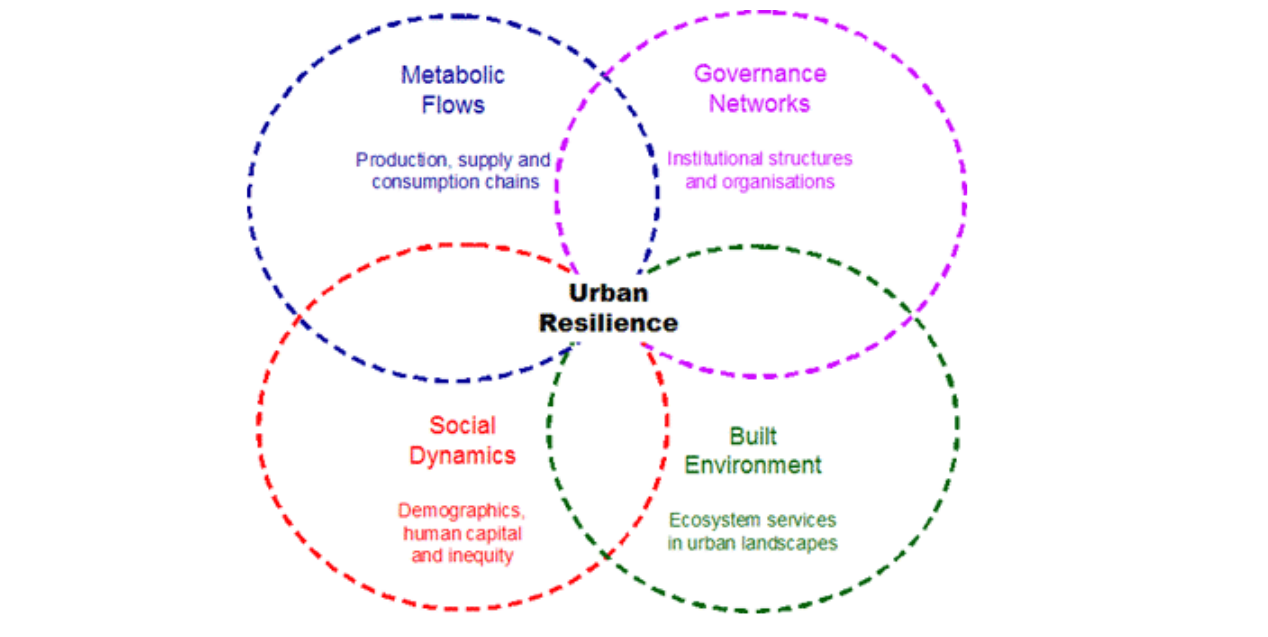
Fig. 2. Classroom learning about resilience. Urban resilience concepts explored in the Urban Environments class. Source: Resilience Alliance website. [online] URL: http://www.resalliance.